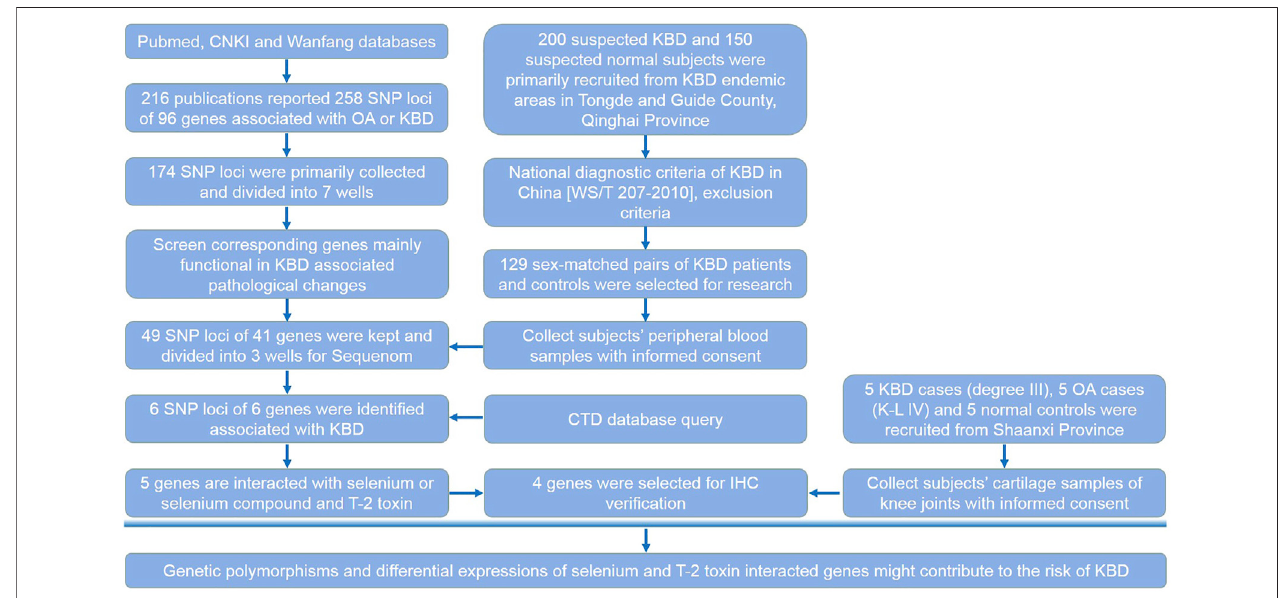
FIGURE 1 | Research design. This fl ow chart shows the selection process of candidate SNP loci and corresponding genes, subjects recruited and sample collection procedures, and the main methods and technologies used in this study.